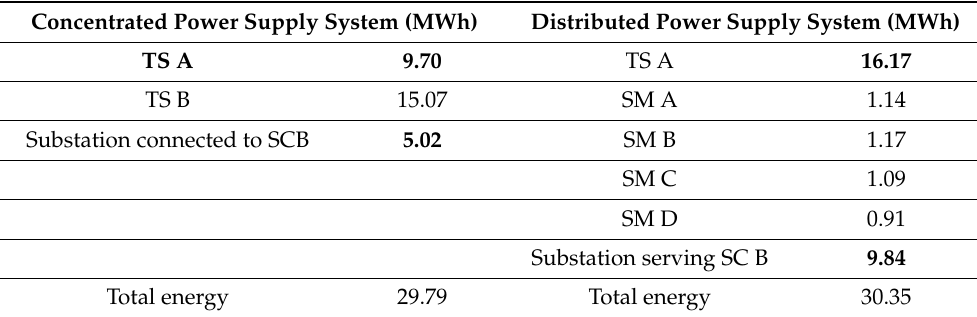
Table 2. Energy drawn from traction substations/supplying points during a 24-h